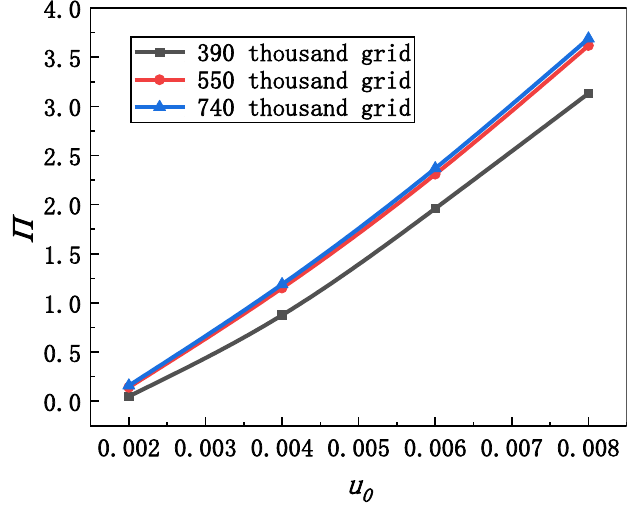
Figure 4. Dimensionless pressure drop ratio to inlet velocity.